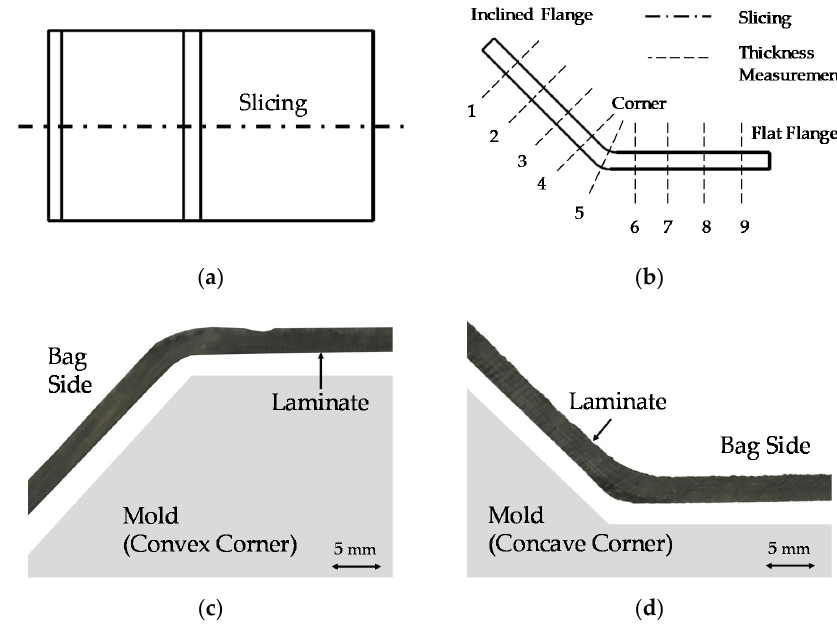
Figure 4. Schematics of ( a ) slicing of composite laminate from the center in a longitudinal direction and ( b ) cross-sectional view of composite laminates with thickness measurement locations. The actual specimens slicing and thickness measurement criteria are uniform in both ( c ) concave- and ( d ) convex- cornered composite laminates.